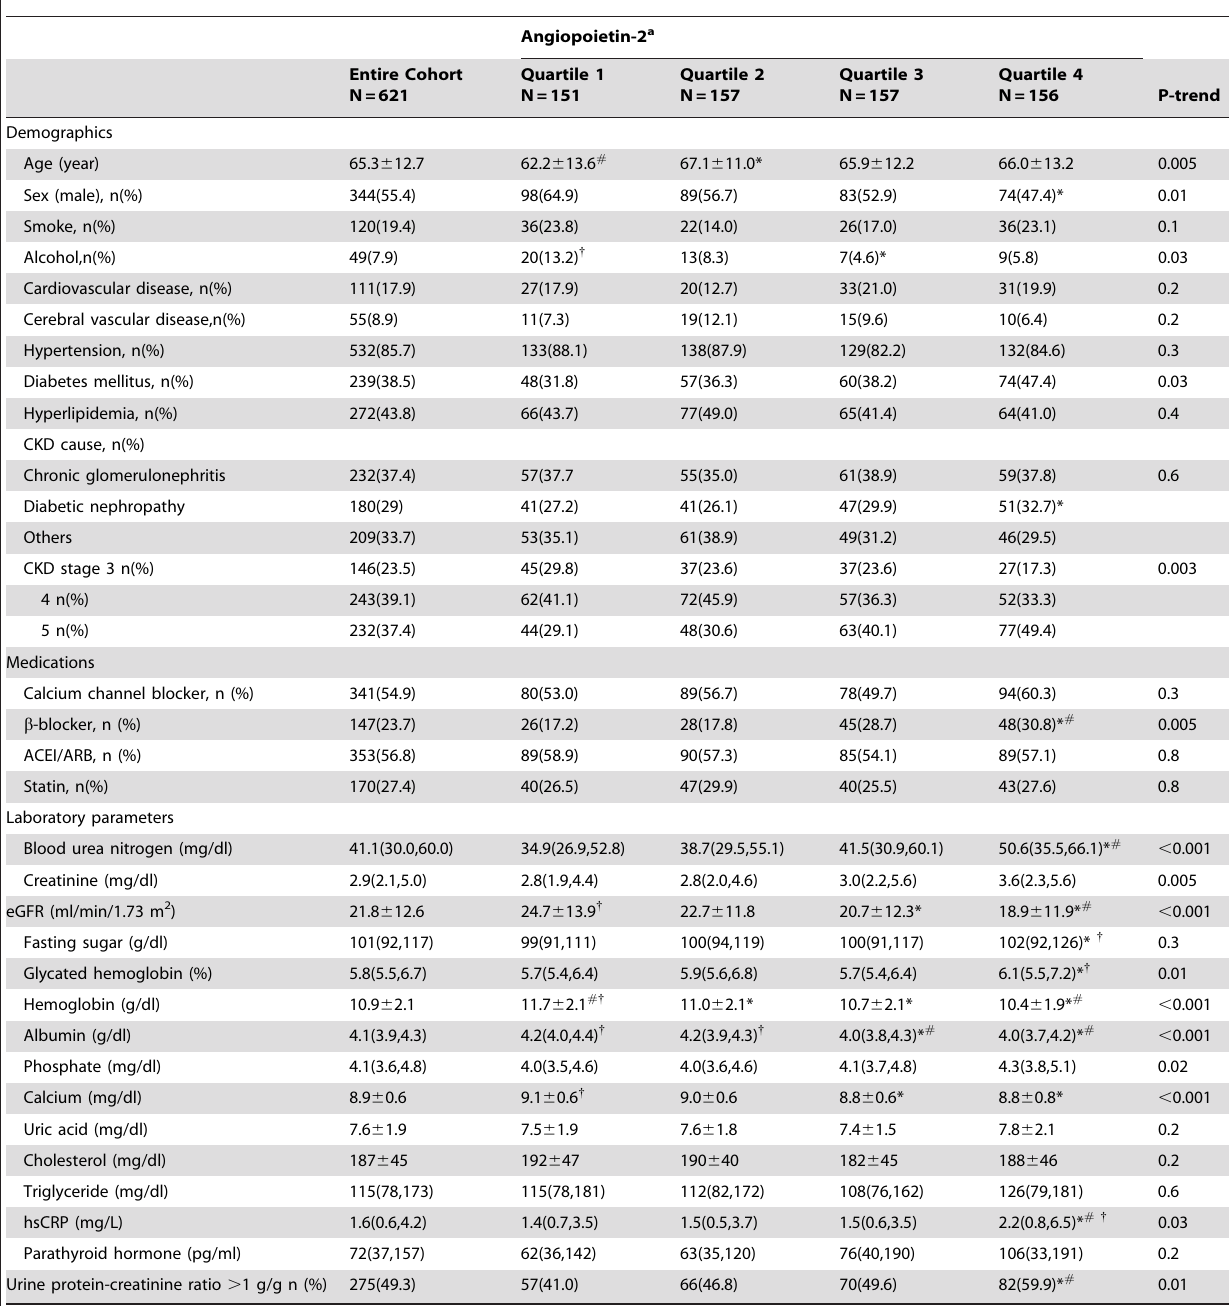
Table 1. The clinical characteristics of study subjects stratified by angiopoietin-2